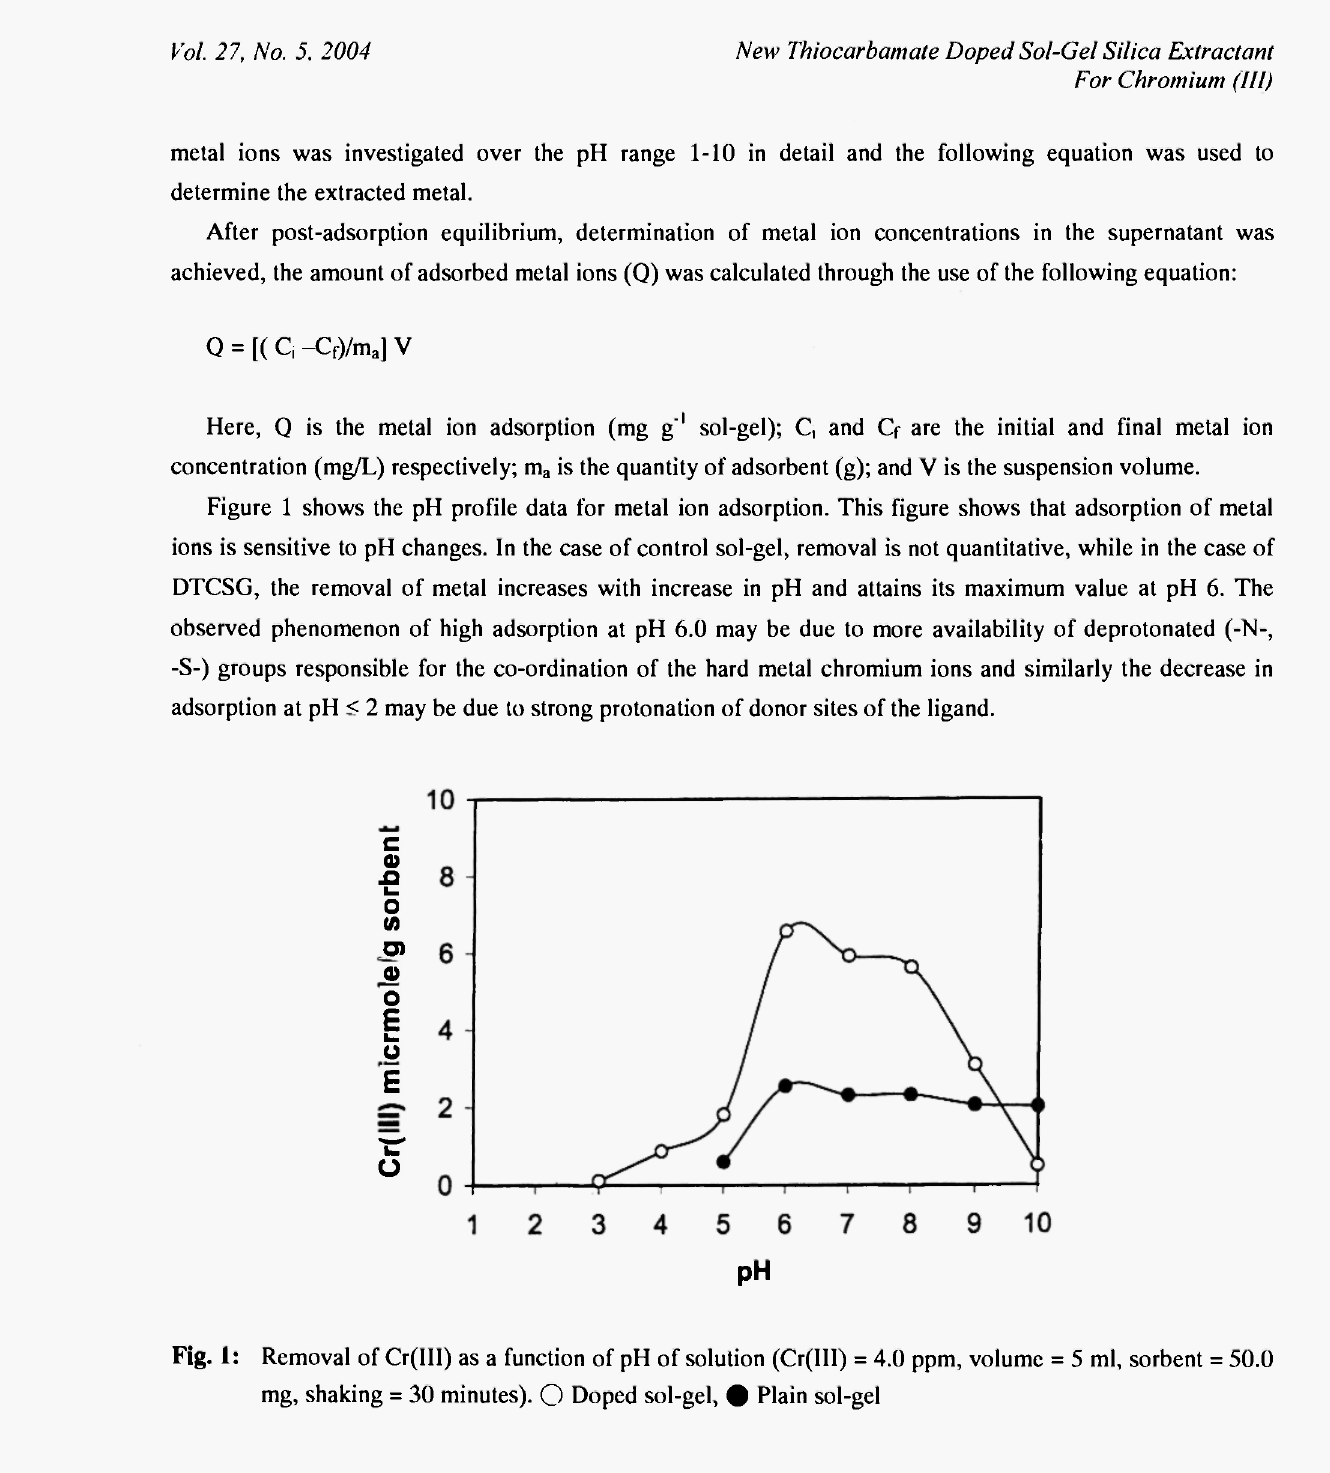
Fig. 1: Removal of Cr(III) as a function of pH of solution (Cr(III) = 4.0 ppm, volume = 5 ml, sorbent = 50.0 mg, shaking = 30 minutes). Ο Doped sol-gel, # Plain sol-gel